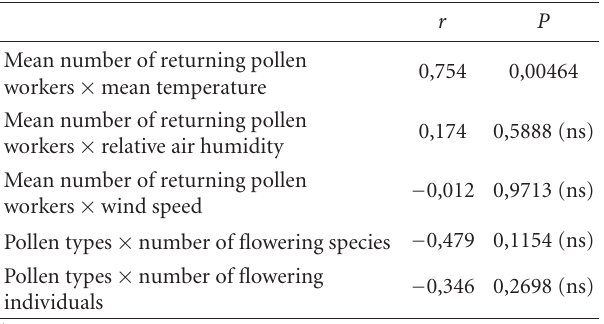
Table 1: Pearson coe ffi cients ( r ) between the mean number of returning foraging workers and climatic factors and between pollen collected and resource